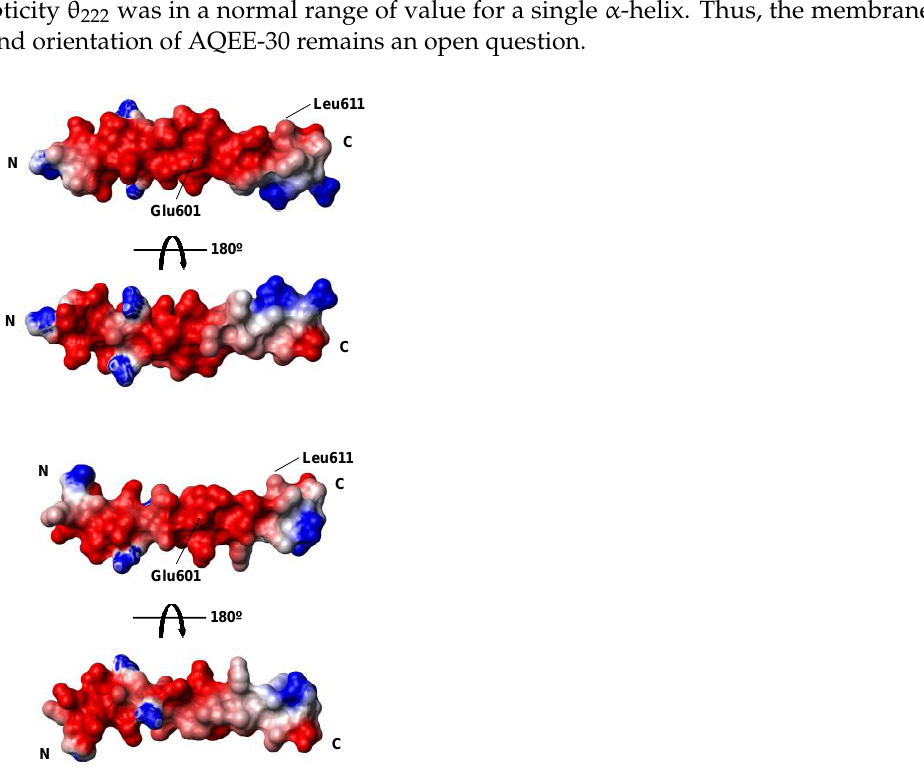
Figure 5. Electrostatic potential at the surface of AQEE-30 structures ( A ) in the HFIP solution and ( B ) in the DPC solution. Boundary residues, 601 Glu and 611 Leu of the amphiphilic region and termini are indicated.